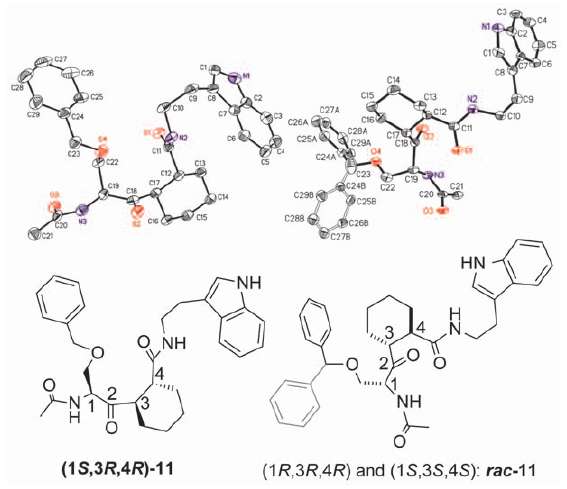
Figure 4. X-ray crystal structures of intermediates (1 S ,3 R ,4 R )-11 and rac -11 are shown above as displacement ellipsoid drawings (50%). The positional disorder of the benzyl group in rac - 11 is shown as lighter lines. Hydrogen atoms are omitted for clarity. Structural depiction of the stereochemistries of (1 S ,3 R ,4 R )-11 and rac - 11 are shown below each crystal structure.